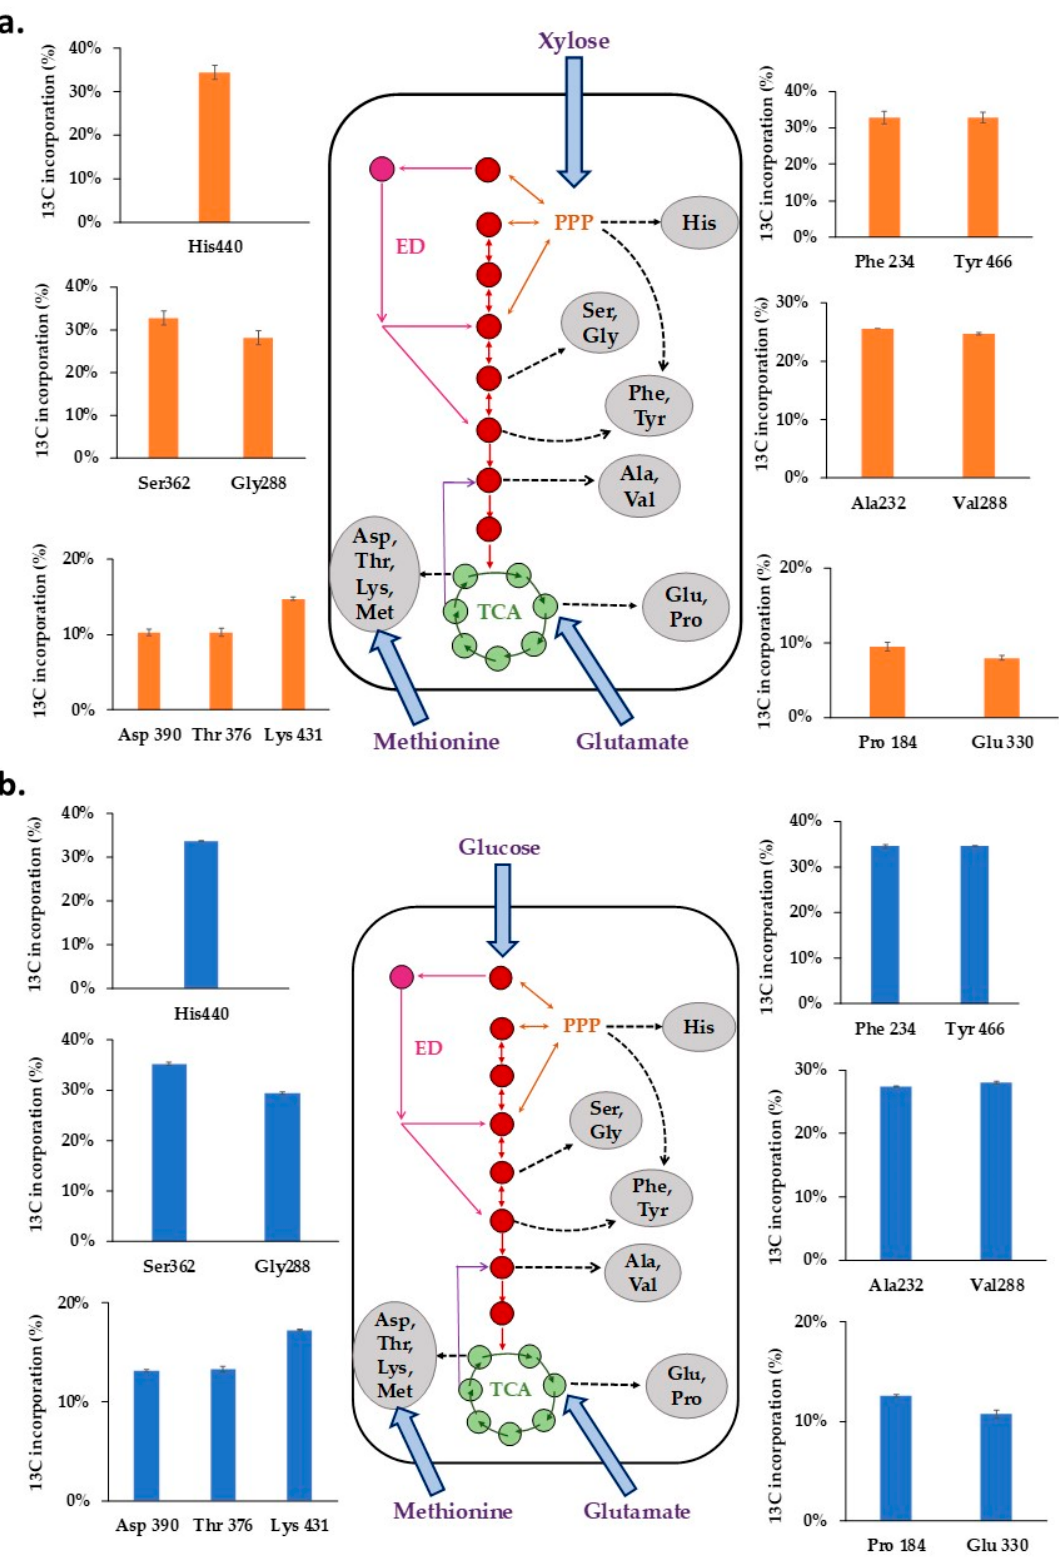
Figure 4. The intracellular fate of the 13 C label in the central metabolic pathway when ( a ) 40% [ 13 C 5 ]xylose and ( b ) 40% [ 13 C 6 ]glucose was fed to Xanthomonas oryzae pv. oryzae BXO43. The average 13 C incorporation (in %) in the representative amino acid fragments, shown as bars, highlight the activities of different metabolic pathways in Xoo. The mass isotopomer abundances of the 12 representative amino acid fragments are presented in Table S4.